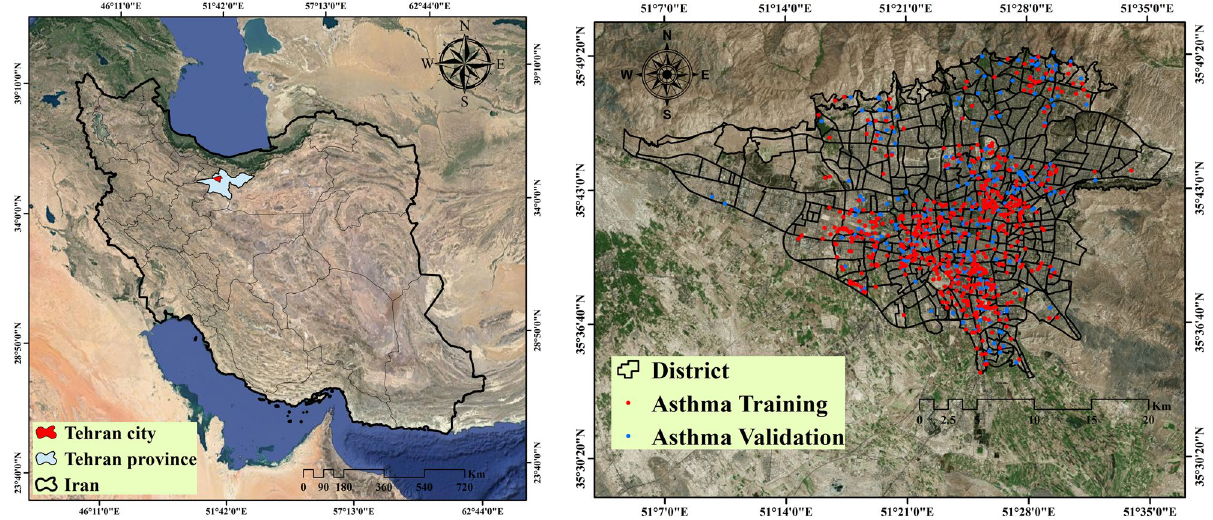
Figure 1. Study area with locations of asthma patients. This map was generated using the tool of ArcGIS 10.3 (ESRI, Redlands, CA, USA,